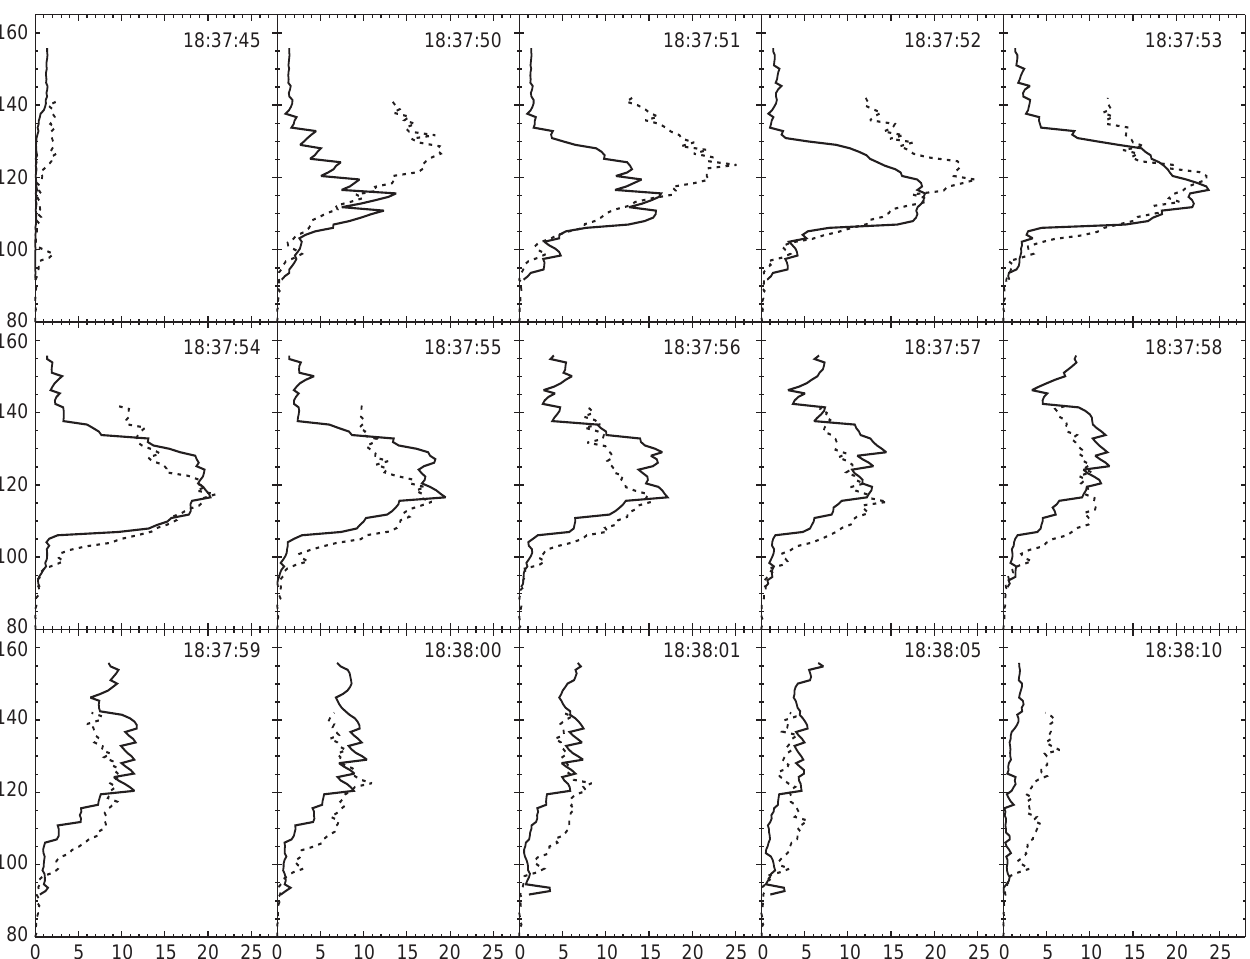
1837:53 UT was used to calibrate the reconstructed optical volume emission to electron densities. A background density profile is always added and the previous profiles were allowed to decrease according to Eq. (15)